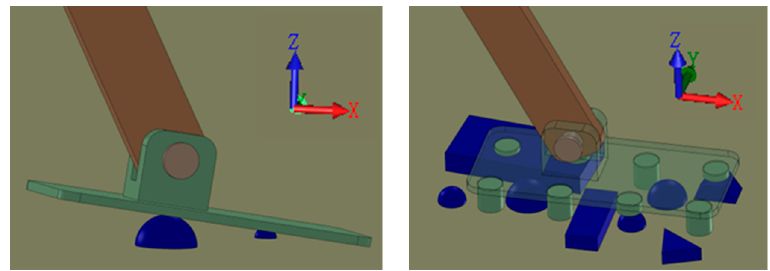
Figure 2. Comparisons between a conventional rigid flat foot and the new foot on the ground with various bumps and obstacles.